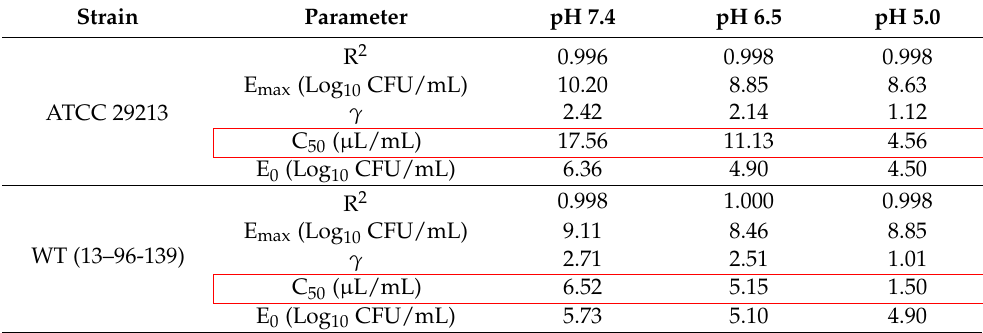
Figure 3. Graphic representation of the antibacterial effect (antibacterial effect (E): ∆ Log colony- forming units (CFU)/mL 24–0 h) of essential oil (EO) against S. aureus ATCC 29213 ( A ); wild type ( n = 3: SA13, SA96, and SA139, using the mean of triplicates for each strain) ( B ); and wild type ( n = 3: SA78A, SA79A, and SA86B, using the mean of triplicates for each strain) ( C ). In the three cases are plotted the E vs. EO concentration at pH 7.4, 6.5, and 5.0. Table 8. Parameters obtained by the sigmoid model applied to curves of the Index E (antibacterial effect) (CFU/mL) vs. EO concentration ( μ L/mL) at pH 7.4, 6.5, and 5.0.